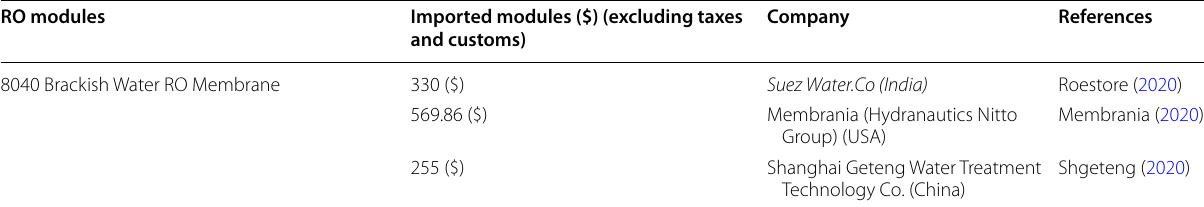
Table 1 RO membranes module price in some companies at 2020–2021 RO modules Imported modules ($) (excluding taxes and